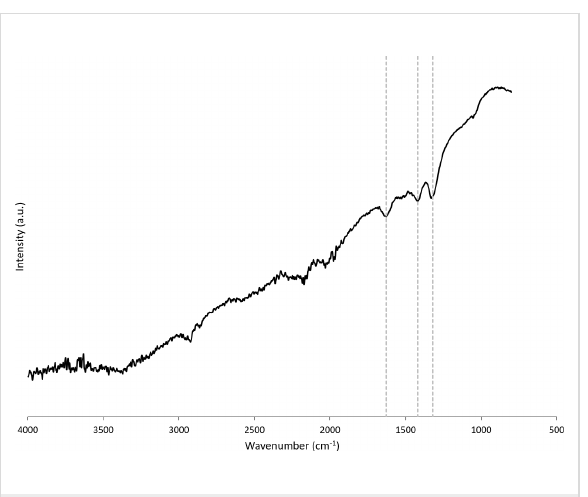
Figure 4: Non-baseline corrected Fourier-transform infrared spectros- copy of NM-212 with peaks indicated by dashed lines at 1630, 1420, and 1320 cm − 1 .